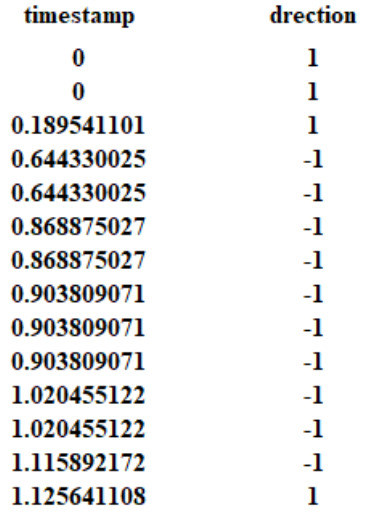
Figure 7. Layers of data transport in Tor.